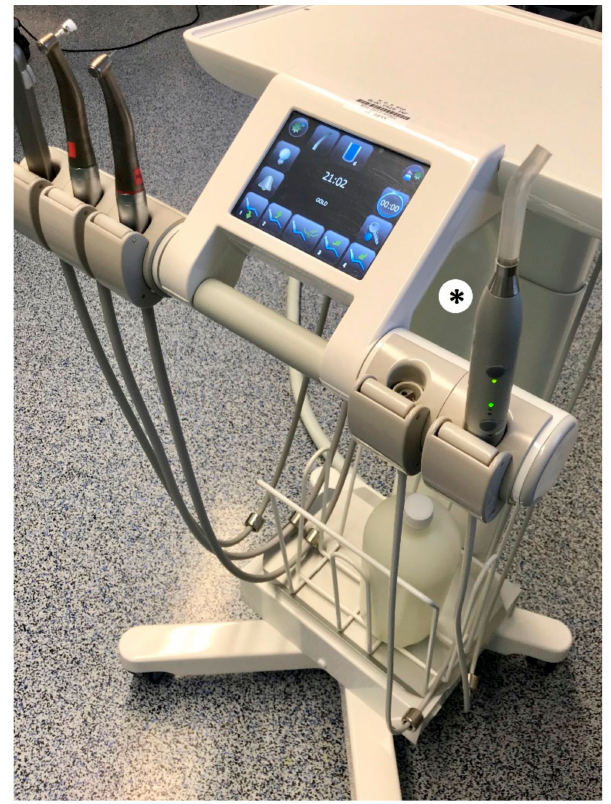
Figure 1. Mobile dental delivery service. * water